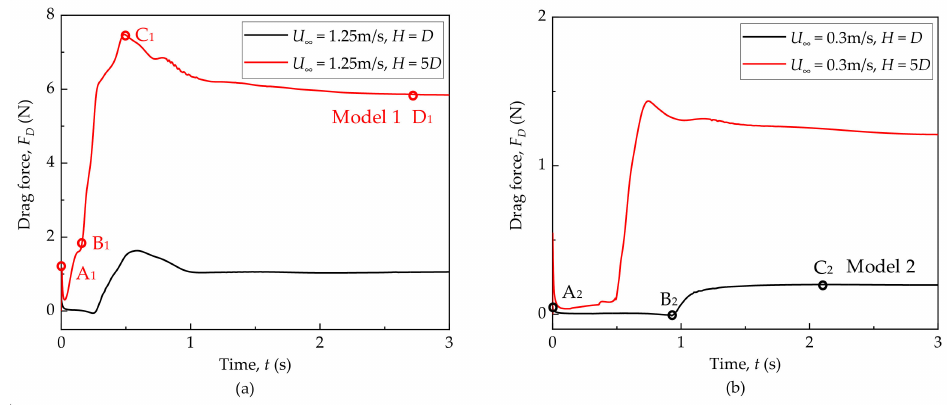
Figure 6. Typical drag force-time curves. ( a ) High velocity condition; ( b ) low velocity condition. The formation mechanism of the models is explained as follows. At point A 1 and A 2 , the landslide body with a certain initial velocity enters the domain from the inlet and pushes the seawater in front so that the originally stationary seawater begins to accelerate to a higher velocity and first impacts the monopile, causing a sharp increase of the force [31]. As the landslide moves forward, the left end and right ends of the pile can be divided into upstream and downstream zones. For model 1, before the debris flows touch the monopile, strong vortices form upstream of the pile, resulting in a negative pressure zone. This slows down the growth of the drag force before point B 1 , as shown in Figure 7a. After between the positive pressure zone and the negative pressure zone increases and the drag body engulfs the monopile, the negative pressure zone becomes narrower. The drag force flow height are lower, it takes longer for the landslide body to meet with the monopile at point B 2 and the drag force is smaller than that of model 1, as shown in Figure 7d. It can be seen from Figure 7e that drag force increases to the stable immediately after point B2 because the pressure difference between the upstream and downstream zones is